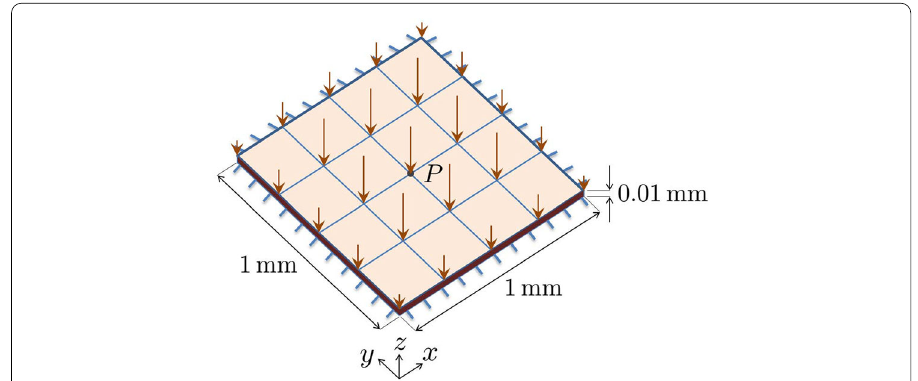
Fig. 12 Thin plate, geometry, boundary conditions, loading and discretization